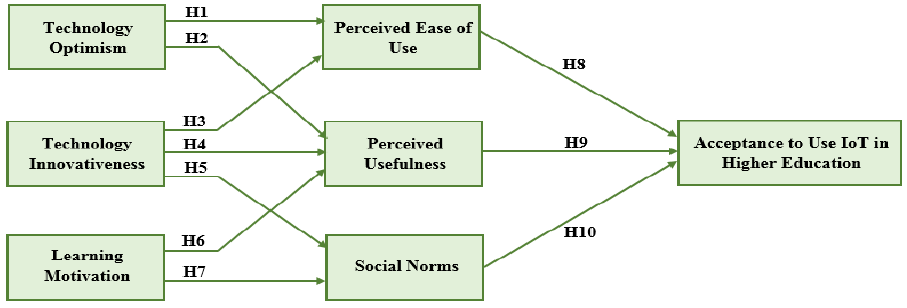
Figure 1. The proposed model.